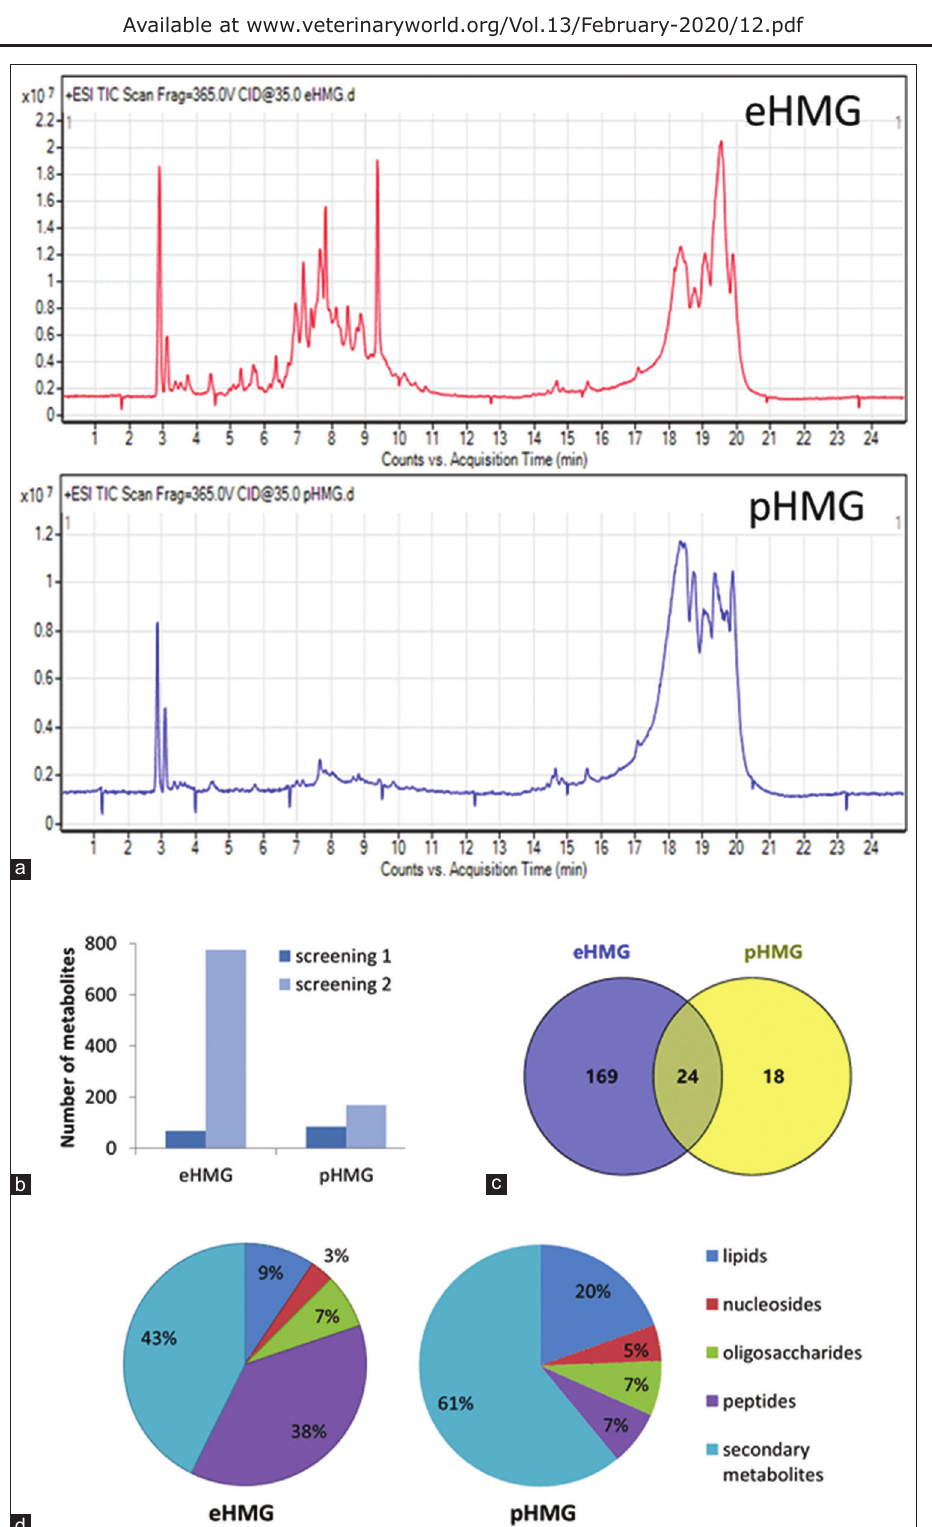
Figure-2: The second liquid chromatography/mass spectrometry (LC-MS) screening with optimized parameters on eHMG and pHMG extracts. (a) Total ion chromatograms of eHMG and pHMG extraction methods selected from the first pre- screening. The LC-MS chromatograms were obtained from ES+mode. (b) The efficiency comparison between the first and second screening for both eHMG and pHMG extracts. (c) The number of metabolites that found similar between pHMG and eHMG extracts. The comparison was made based on the identified metabolites that the contaminant was filtered off. (d) The classification of edible bird’s nest metabolites in eHMG and pHMG extracts. The classification was based on the metabolite identities after removing the